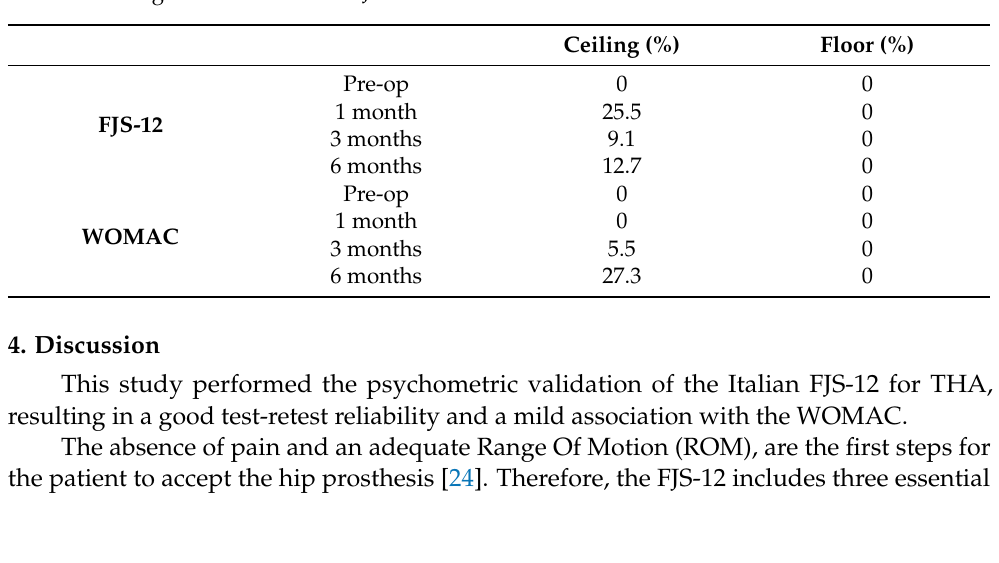
Table 6. Ceiling and floor effect of FJS-12 and